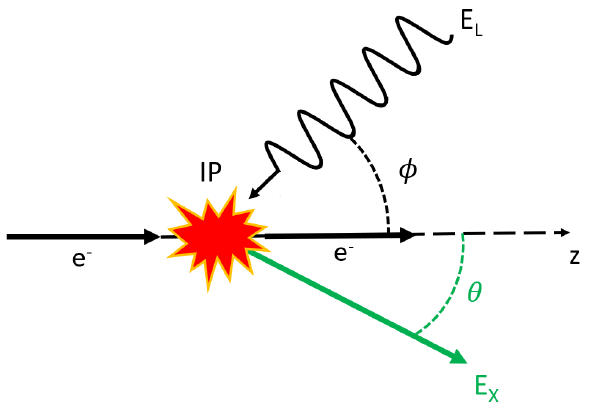
Figure 2. Schematic of an inverse Compton scattering process. The input laser of photon energy E L was upscaled to an X-ray of energy E X